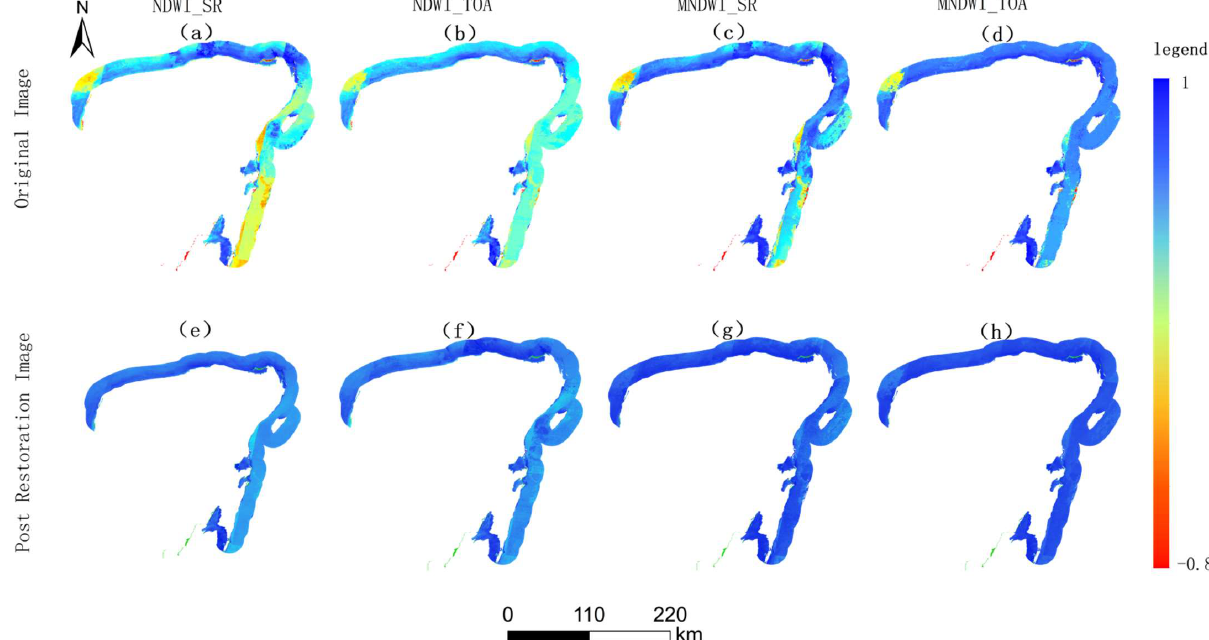
Figure 4. Before and after image restoration in 1998. ( a – d ) Original image; ( e – h ) post-restoration image; ( a , e ) Landsat SR NDWI image; ( b , f ) Landsat TOA NDWI image; ( c , g ) Landsat SR MNDWI image; ( d , h ) Landsat TOA MNDWI image.